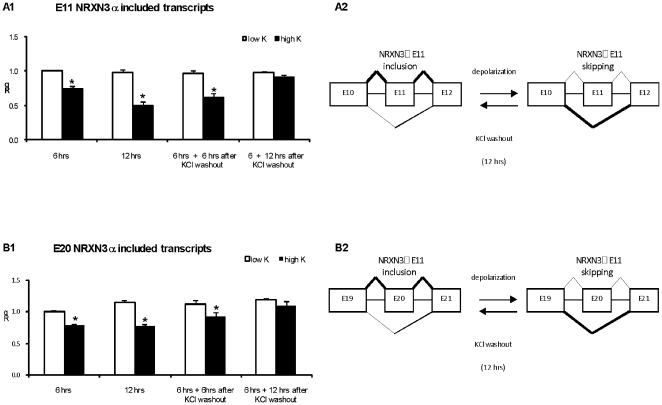
The depolarization-induced repression of E11 NRXN3α splicing is reversible.Real-time PCR quantification of (A1) E11 and (B1) E20 NRXN3α included transcripts expressed in rat cortical neurons incubated with 5 and 50 mM KCl for 6 hours. Reversibility of the induced depolarization effects on the expression of E11 and E20 NRXN3α included transcripts was monitored after 6 or 12 hours of depolarization and following an additional recovery period of 6 or 12 hours in culture medium after KCl washout. Rq values are mean +SEM from at least 3 experiments (* = P<0.05; t-test). (A2-B2) Schematic representation of the high KCl effects on E11 NRXN3α splicing.